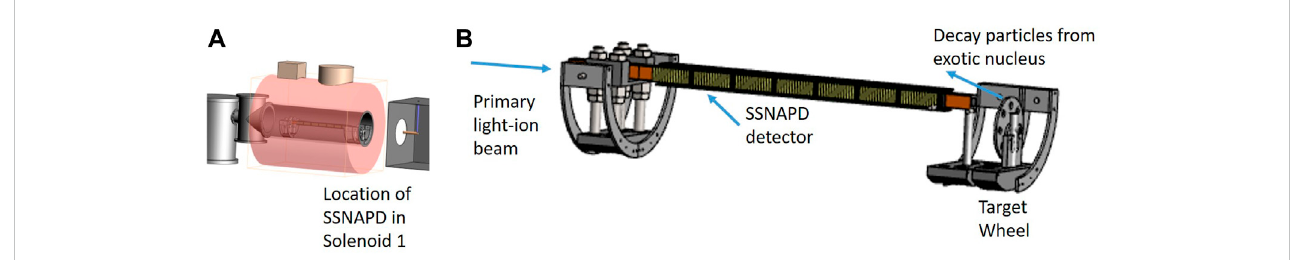
FIGURE 6 (A) TheSSNAPDdetectorwouldsitonaxisatthecenterof TriSol solenoid1. (B) ThebeamistunedthroughSSNAPDtobombardatarget attheexitofthe solenoid. Decay particles would spiral backwards in the solenoidal magnetic fi eld to be detected back on axis by SSNAPD.